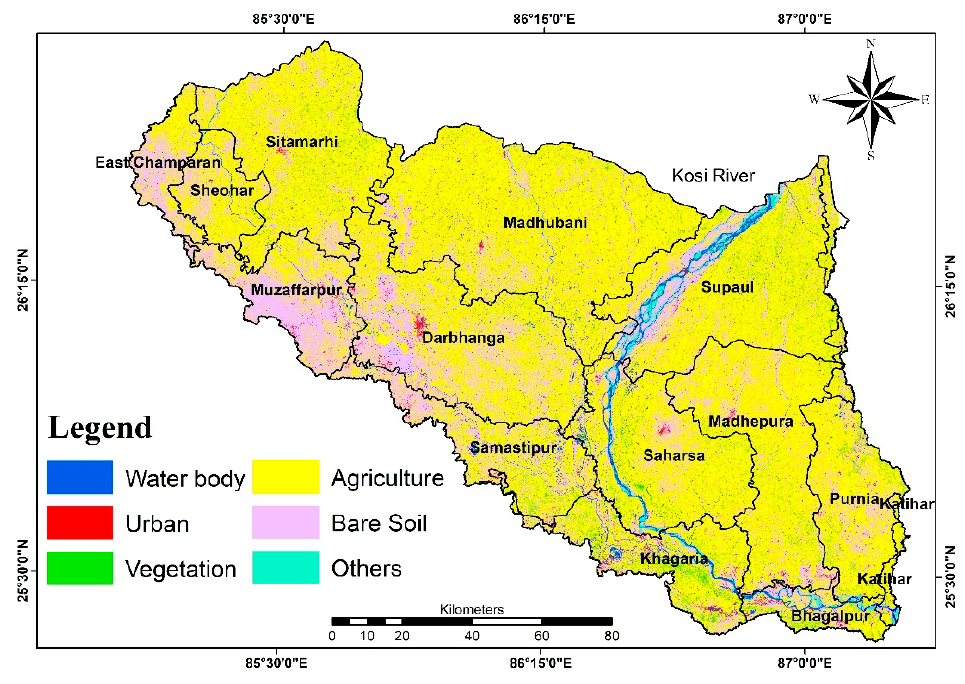
Figure A1. Land use Land cover map of North Bihar as derived from Sentinel-2 satellite data. Table A1. Measurement of in-situ SSM using TDR-300 at different sample plots in KRB and corre- sponding coordinates.